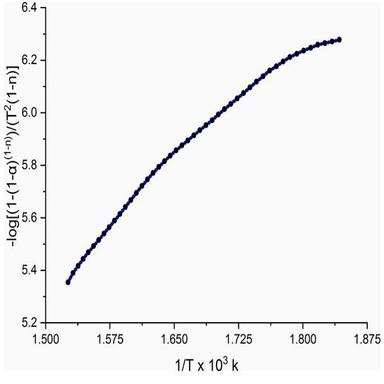
PLOT OF COATS-REDFERN RELATION